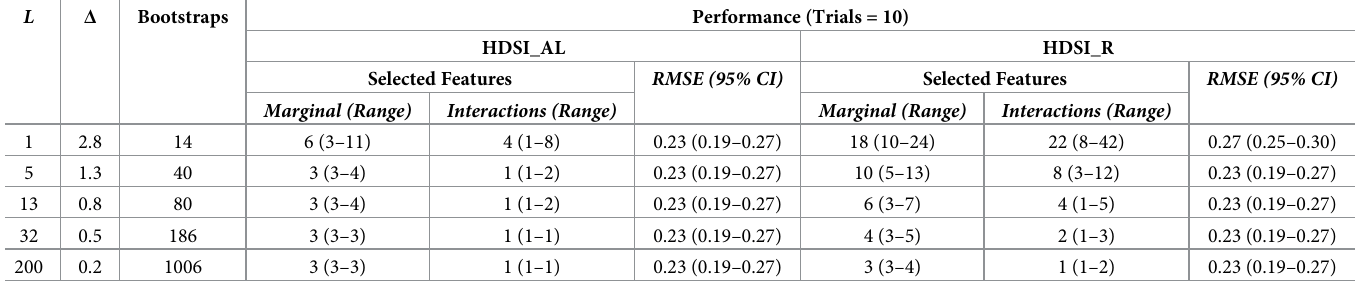
Table 3. HDSI performance in different